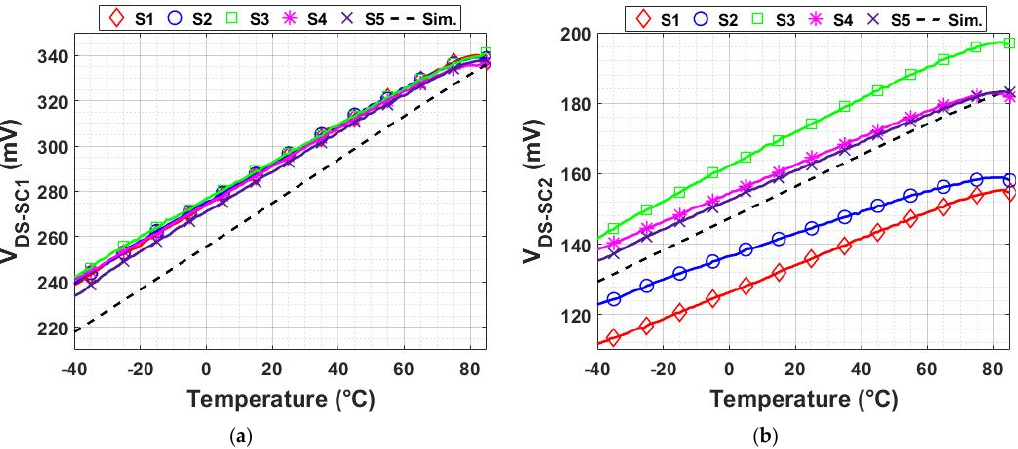
Figure 19. The measured output voltage of ( a ) SCCT1 and ( b ) SCCT2 as a function of temperature. The supply voltage sweep shows a minimum V DD of operation close to 1.1 for V REF and 0.7 V for the bias current generator. The simulated power supply rejection ratio (PSRR) at DC is − 55 dB and − 90 dB for the supply voltages of 1.1 V and 2.5 V, respectively. The current supply and the power consumption (@ 1.1 V) of the proposed circuit are 680 nA and 748 nW, respectively. Finally, Table 8 summarizes the main measured results discussed so far. ( a ) ( b ) Figure 20. Supply voltage variation of ( a ) V REF and ( b ) I REF . Table 8. Summary of results. V REF @ 27°C Mean (mV)